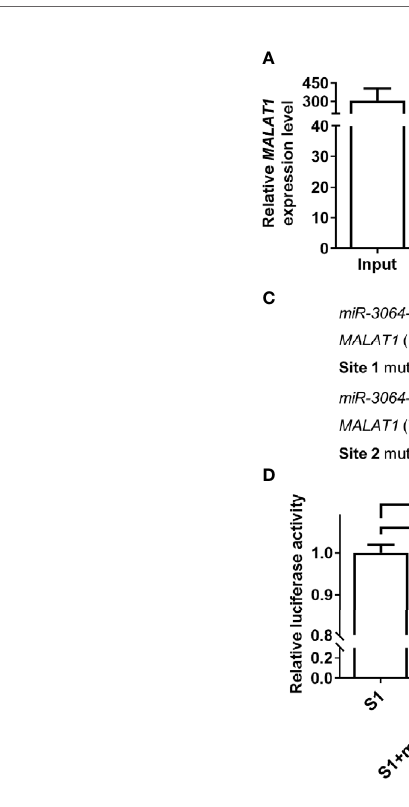
FIGURE 5 | MALAT1 binds to miR-3064-5p directly. (A, B) RIP using antibody against AGO2. The relative RNA levels of MALAT1 (A) and miR-3064-5p (B) were quanti fi ed and normalized to the IgG group using qPCR. Input: positive control; IgG: negative control. (C) Schematic representation of fi re fl y reporter constructs containing the fragments of Site 1 (1,279~1,302 bp) and Site 2 (7,837~7,860 bp) of MALAT1 , and mutants with mutation at the binding sites of miR-3064-5p . (D, E) Luciferase reporter assays of MALAT1 fragment with wild-type or mutant (m) Site 1 (D) or Site 2 (E) in cells overexpressing miR-3064-5p mimic. HEK-293T cells were transfected with miR-3064-5p mimic and fi re fl y/ Renilla plasmids. The relative fi re fl y luciferase activity was measured and normalized to Renilla luciferase activity. Data shown are the means ± SDs (n=3). * P <